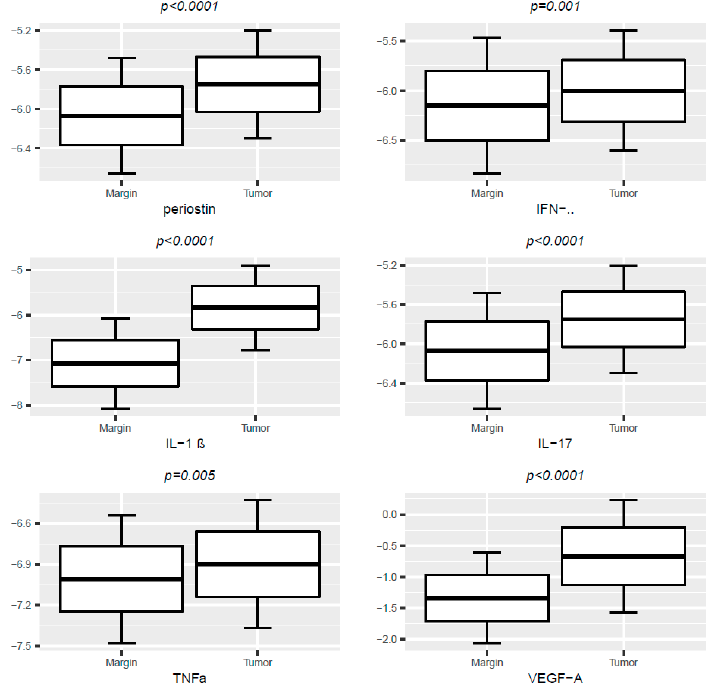
Figure 1. Box-plot- levels of periostin, VEGF-A, IFN- γ , IL-1 β , IL-17, TNF α molecules in tumor and tissue margins; protein levels are presented as log-transformed values as g/g. Paired T-student’s test.